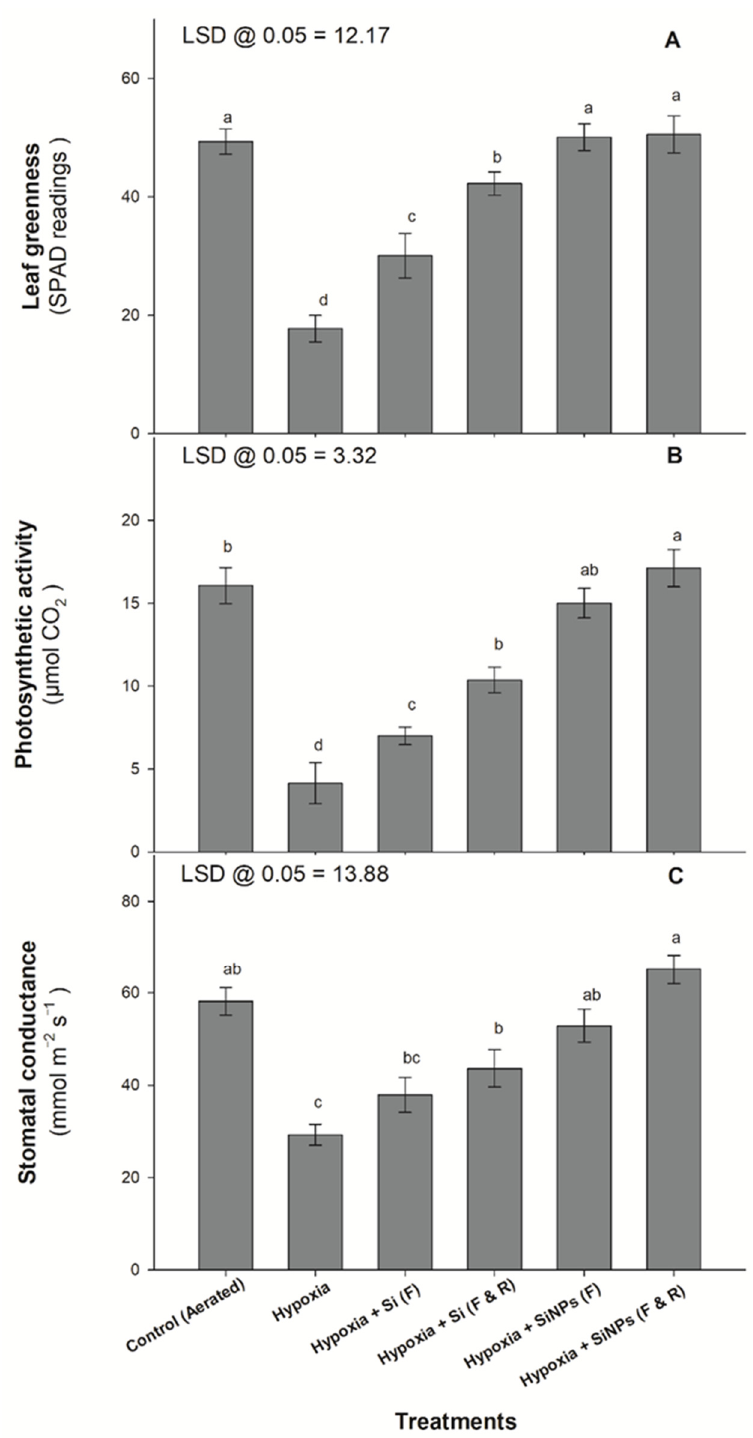
Figure 2. Leaf greenness ( A ), photosynthetic activity ( B ), and stomatal conductance ( C ) in leaves of blueberry plants in response to six treatments i.e., (i) control (aerated), (ii) hypoxia, (iii) hypoxia + Si (F), (iv) hypoxia + Si (F & R), (v) hypoxia + SiNP (F), (vi) hypoxia + SiNPs (F & R). Values are mean of four independent replicates ( n = 4) ± standard error (SE; shown in vertical bars), and values denoted by different letters (in small alphabets) differ significantly at p < 0.05, using the Least Significant Difference (LSD) test. The abbreviations used are F: foliar application of Si or SiNP; F & R: combined foliar and root zone application of Si; R: root zone application of Si or SiNP; Si: conventional silicon; SiNPs: silicon nanoparticles.